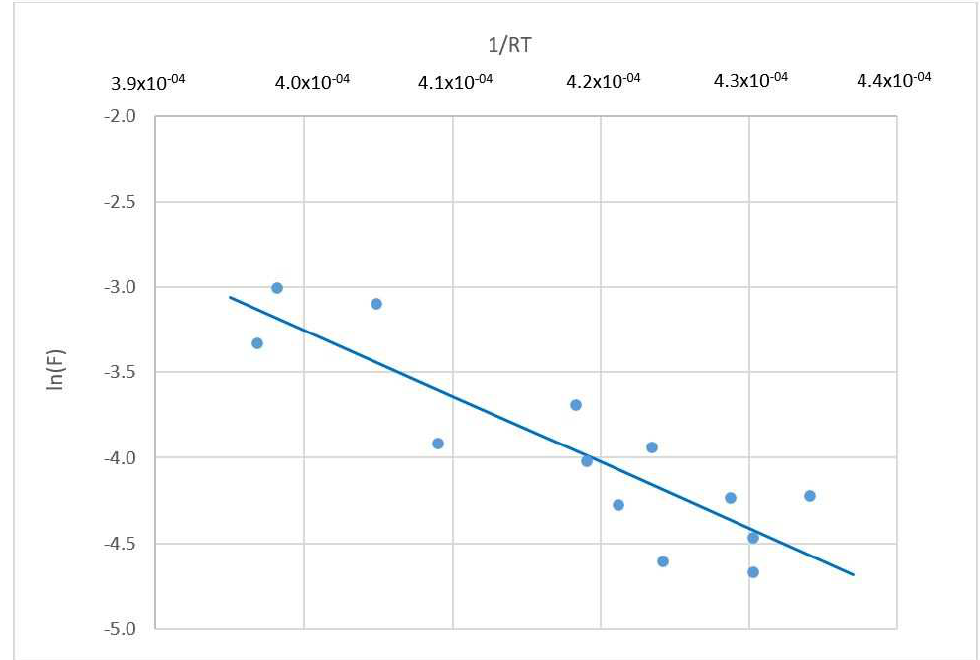
Figure 7. Representation of ln(F) versus 1/RT.